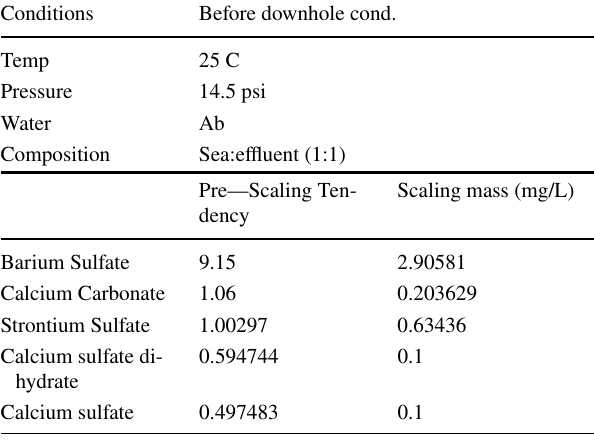
Table 2 Scale prediction for the selected water mix ratio prior to downhole conditions